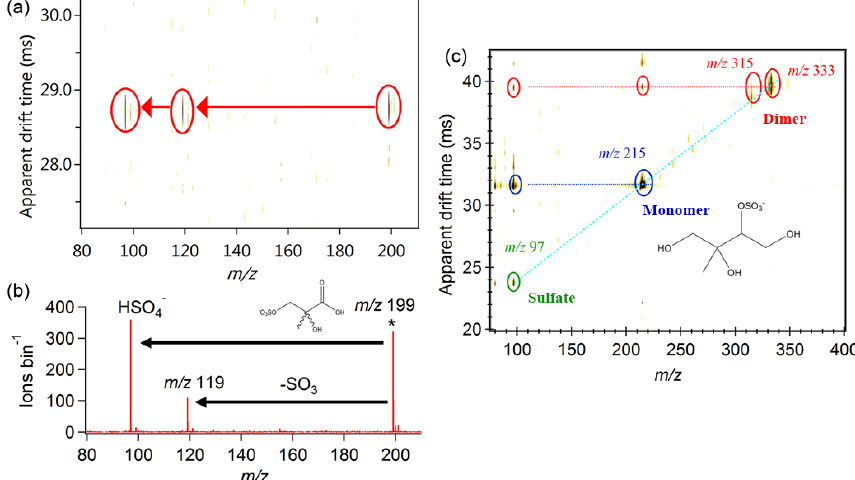
Figure 5. (a) 2-D IMS–CID-MS plot for a synthesized chemical standard of 2-methylglyceric acid organosulfate derivative and (b) its characteristic fragment ion mass spectrum. The CID mass spectra match previously published MS/MS measurements (Gómez-González et al., 2008). (c) 2-D IMS–CID-MS plot of a chamber-generated aerosol filter sample. Organic aerosol was generated in the UNC smog chamber from the reactive uptake of authentic IEPOX onto acidic sulfate aerosol under dark conditions (Lin et al., 2012, 2014). Deprotonated and dehydrated organosulfate dimers and monomers are observed. The organosulfate dimer ( m/z 333) is observed decaying into the organosulfate monomer ( m/z 215) and both are observed further decomposing into HSO − , which also matches previous literature results (Surratt et al., 4